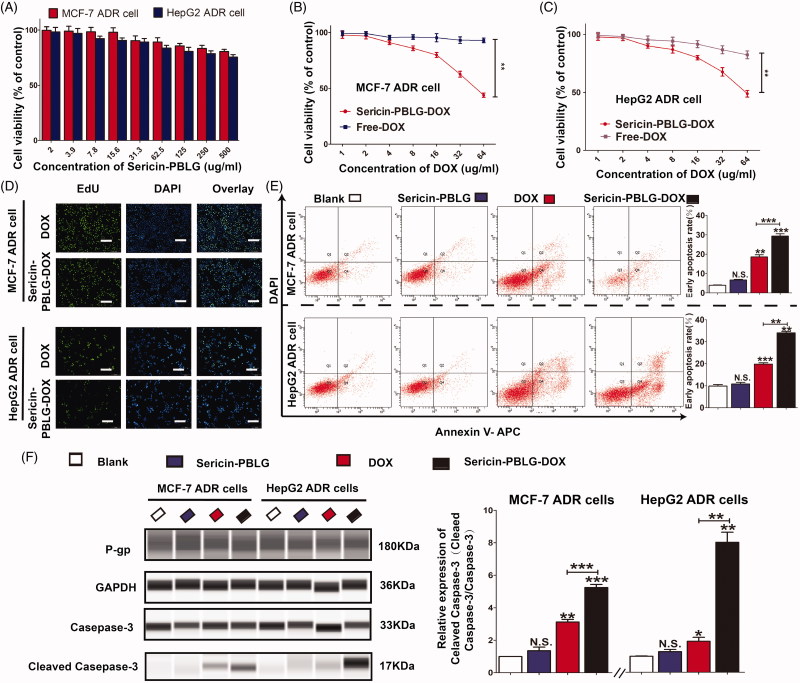
In vitro anti-tumor effect of sericin-PBLG-DOX. (A) Viabilities of MCF-7 ADR cells and HepG2 ADR cells after incubation with the sericin-PBLG nanocarrier. (B and C) Viabilities of MCF-7 ADR cells and HepG2 ADR cells after incubation with DOX or sericin-PBLG-DOX. (D) EdU assay of MCF-7 ADR cells and HepG2 ADR cells after incubation with DOX or sericin-PBLG-DOX. Scale bar, 200 nm. (E) Apoptosis rates of MCF-7 ADR cells and HepG2 ADR cells after incubation with DOX or sericin-PBLG-DOX. (F) Protein expression of P-pg, caspase-3, cleaved caspase-3 protein, and GAPDH in MCF-7 ADR cells, and HepG2 ADR cells after incubation with sericin-PBLG, DOX, or sericin-PBLG-DOX for 48 h (left), and the corresponding quantification of the gray value for each protein (right). Data are shown as the mean ± SD, n = 3, N.S. indicates p > .05, * indicates p < .05, ** indicates p < .01, and *** indicates p < .001.